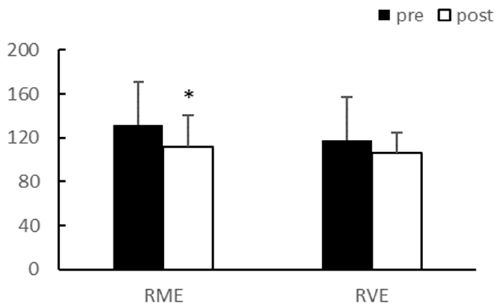
Figure 4. TG (mg/dL). TG, Triglyceride; ** p < 0.01.